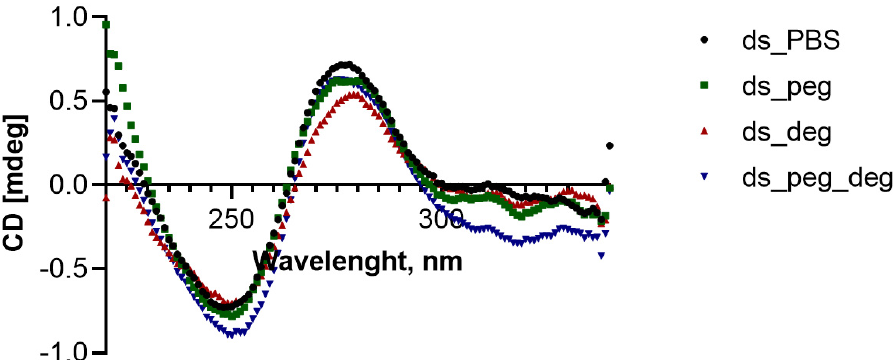
Figure 3. Circular dichroism (CD) spectra of the ds (Bmut-CoBmut) without fluorescent dyes in four different buffer conditions (pure PBS, peg buffer, deg buffer, and mixed peg_deg buffer). Peg is polyethylene glycol, and deg is diethylene glycol dimethyl